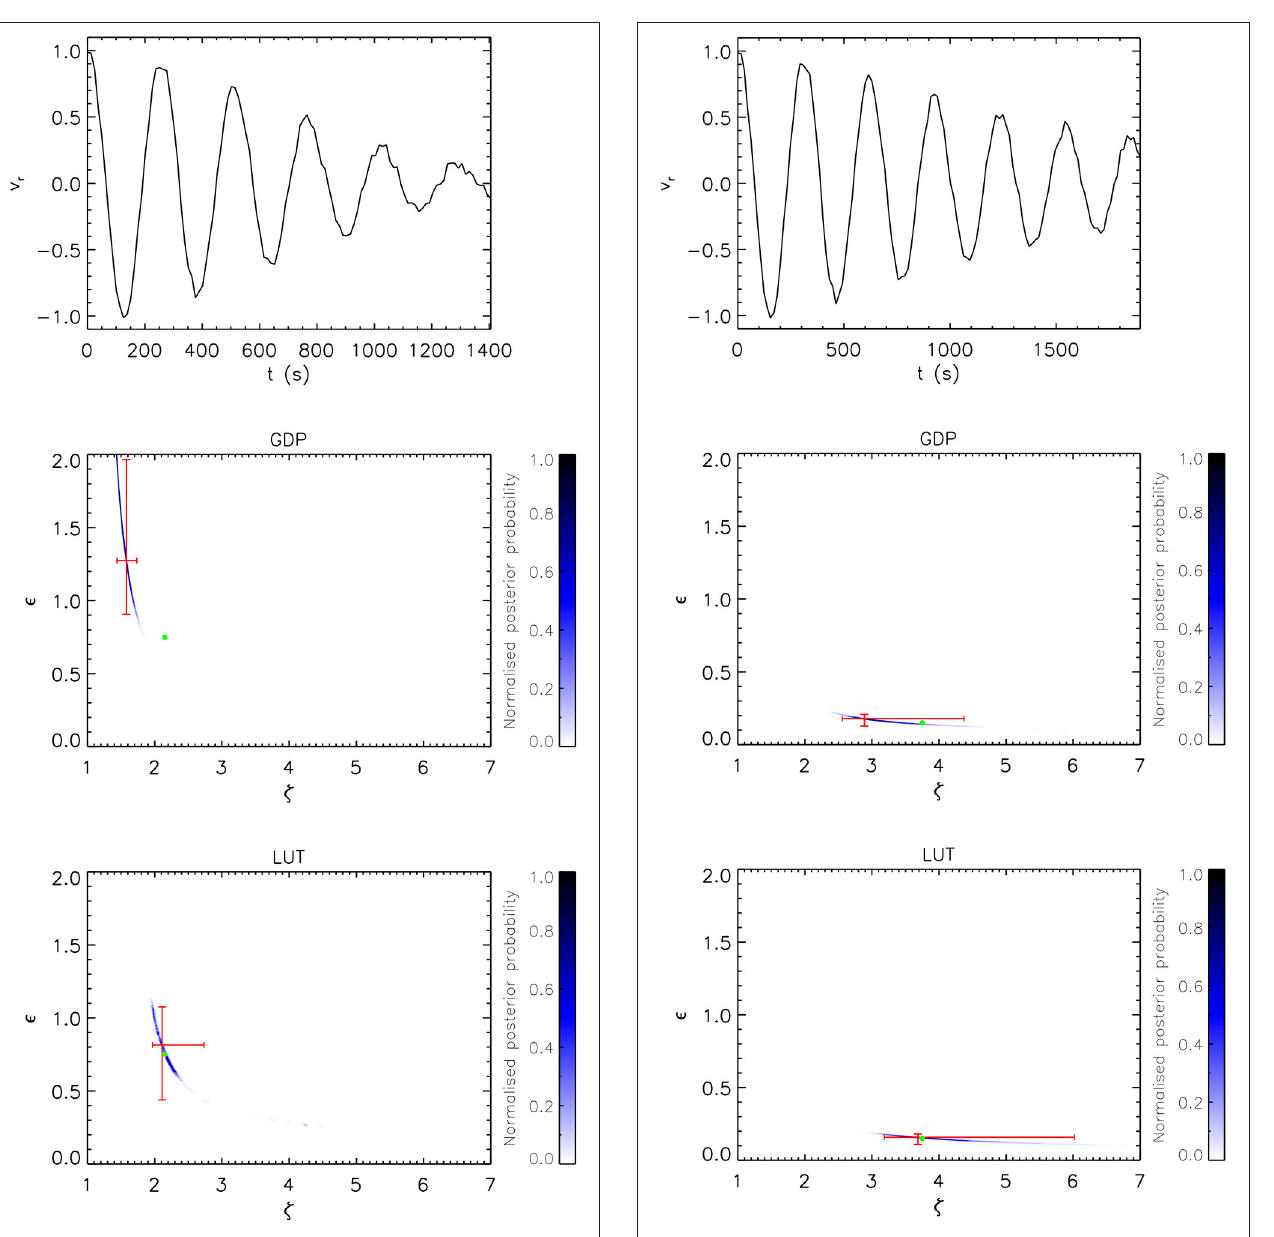
FIGURE 8 | The top panel shows a test kink oscillation simulated for ζ = 2.15 and ǫ = 0.75 with noise added. The middle and bottom panels show the seismologically estimated transverse density structure based on the GDP and LUT methods, respectively. The color contours represent the normalized 2D histograms approximating the marginalized posterior probability density function. The red error bars correspond to the MAP value and 95% credible intervals, and the green circle indicates the actual density profile parameters.